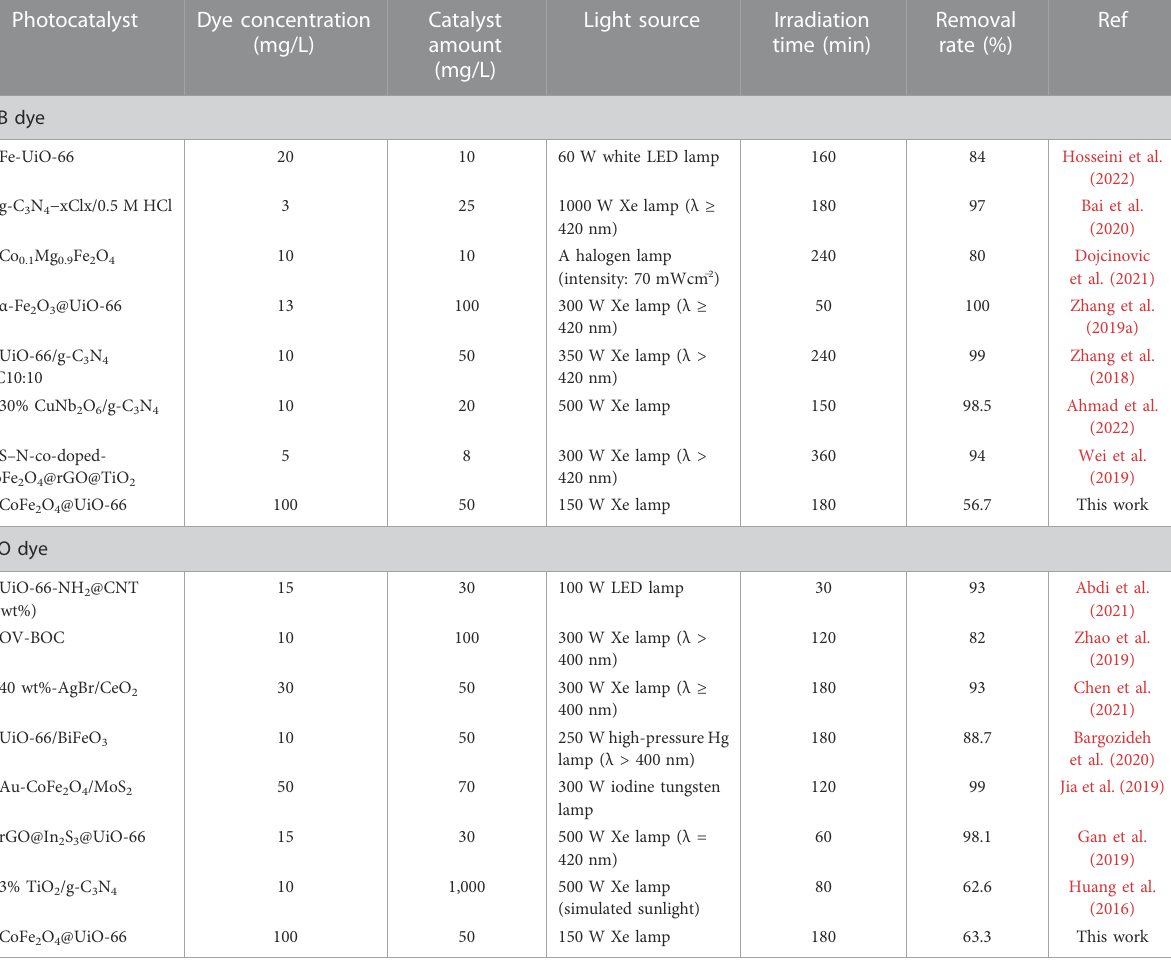
and CoFe 2 O 4 are excited, generating electrons (e – ) and holes (h + ) in their CB and VB, respectively. Since, the CB potential of CoFe 2 O 4 ( – 0.56 V) is more negative than the LUMO of UiO-66 ( − 0.44 V), the excited electrons can directly transfer through the interface channels formed by the heterojunction to the LUMO of UiO-66, suppressing the recombination of photogenerated carriers (Wang et al., 2021d; Gao et al., 2021). Subsequently, the photoinduced electrons at LUMO of UiO-66 can reduce the dissolved oxygen to yield (cid:129) O 2 − radicals. Meanwhile, the photogenerated holes would transfer from the VB of UiO-66 (+3.40 V) to the VB of CoFe 2 O 4 (+1.07 V). However, as the VB potential of CoFe 2 O 4 (+1.07 V) is lower than the redox potential of – OH/ (cid:129) OH (1.99 V vs NHE), the photogenerated holes cannot oxidize H 2 O to produce (cid:129) OH radicals (Wang et al., 2022). Instead, the accumulated holes promptly degrade the dye molecules because of their strong oxidation properties. Otherwise, (cid:129) OH reactive radicals could be indirectly generated through (cid:129) O 2 − radicals at the CB of the photocatalyst (Zou et al., 2021). This is consistent with the results of quenching